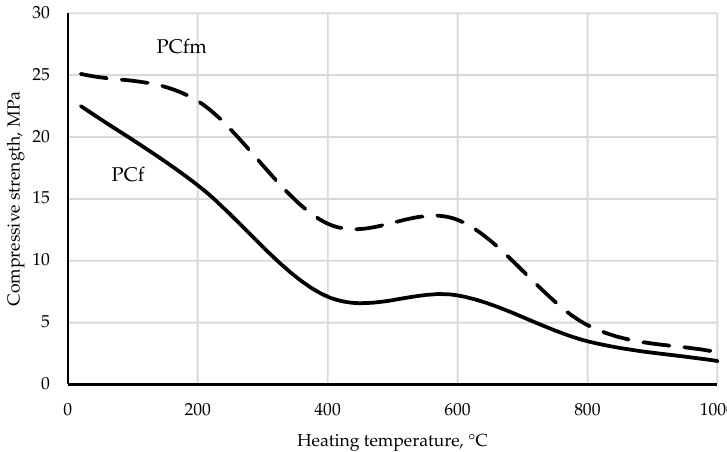
Figure 6. Change in compressive strength of PCf and PCfm concretes.